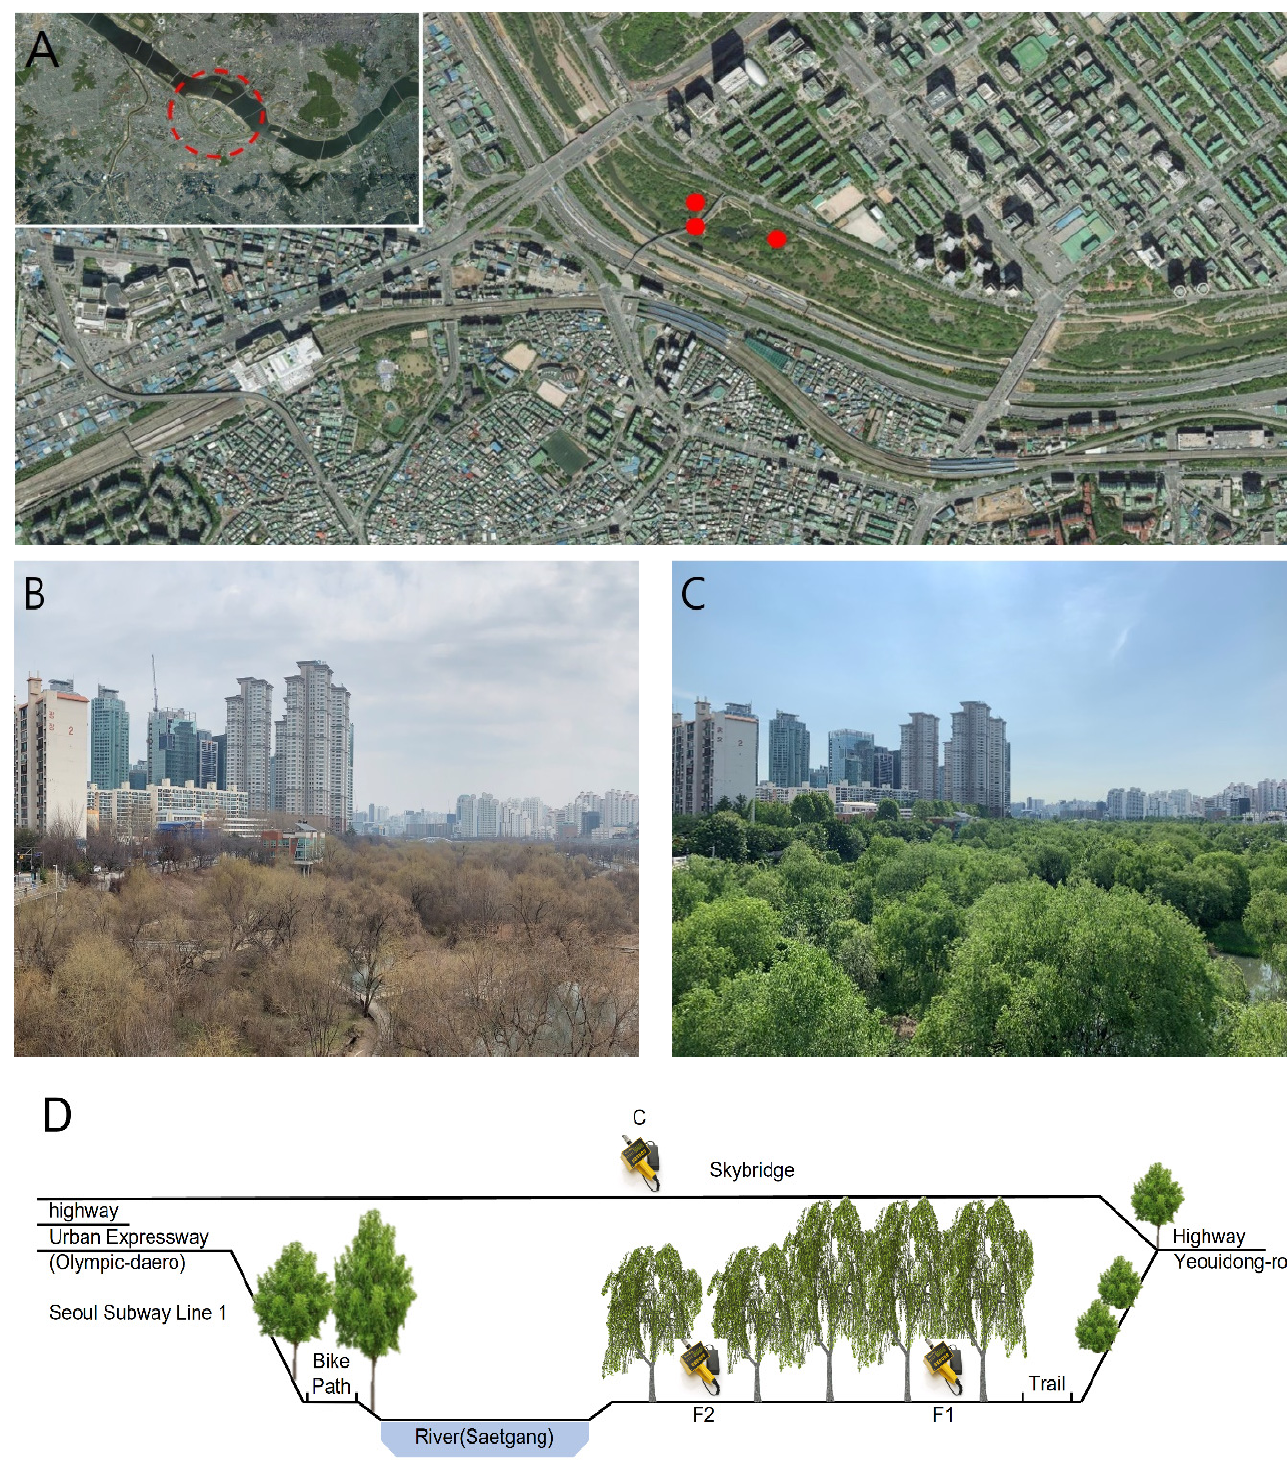
Figure 1. ( A ) Location of the study area in Yeouido Saetgang Ecological Park in Seoul, Korea. ( B ) View of Yeouido Saetgang Ecological Park before leaf emergence in March. ( C ) View of Yeouido Saetgang Ecological Park after leaf emergence in May. ( D ) Figure of the measuring points.